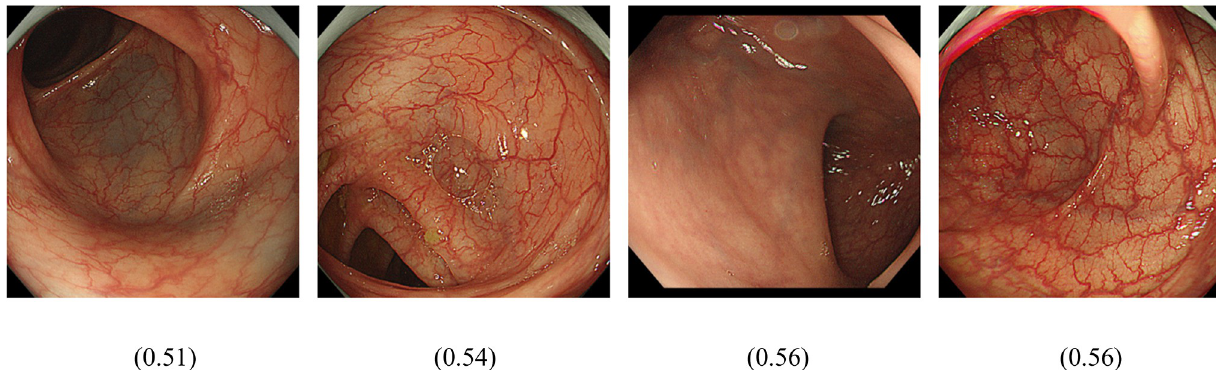
Fig 3. Images that scored relatively high (0 to 1) in the colon image AI model for detecting Group N are shown. Values shown correspond to score.